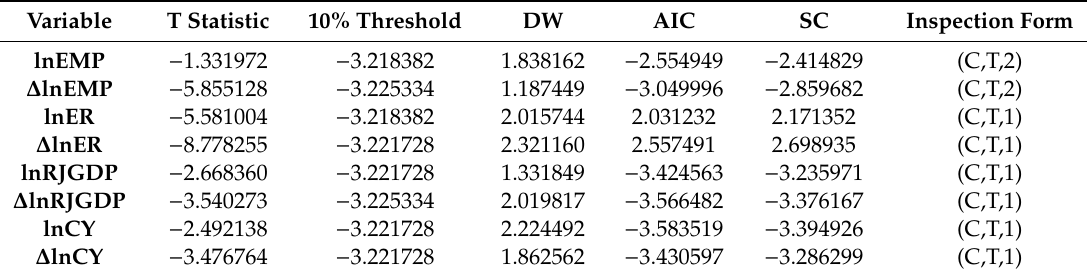
Table 1. Augmented Dickey-Fuller test (ADF) stationarity test